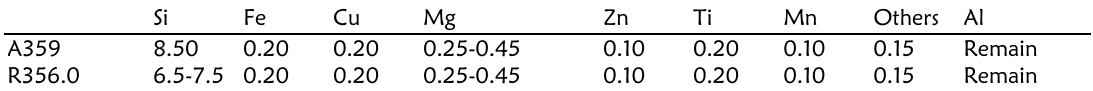
Table 1: Compositions of R356.0 filler material [24] and A359 aluminum matrix [25].